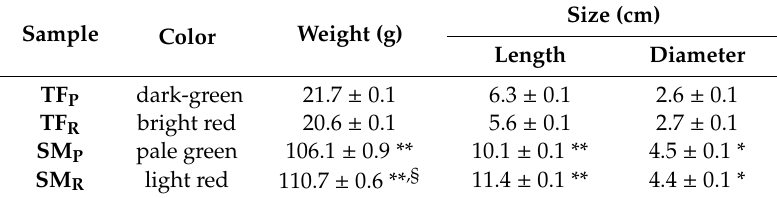
Table 3. Color, weight, and size (length and diameter) of both pink and red fruits from